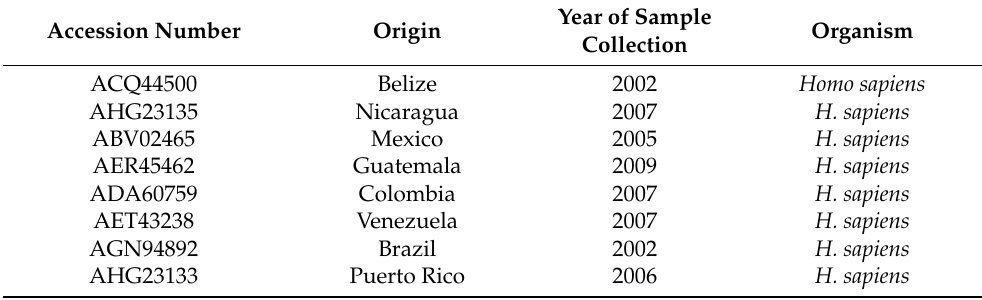
Table 1. The sequences of the NS5 region of DENV-2 RdRp from several countries accessed from